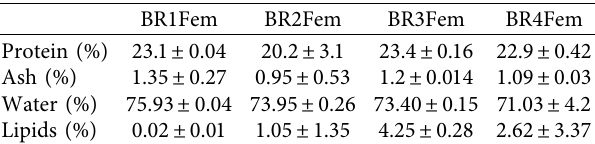
Table 1: Proximate composition of femur broiler chicken from four